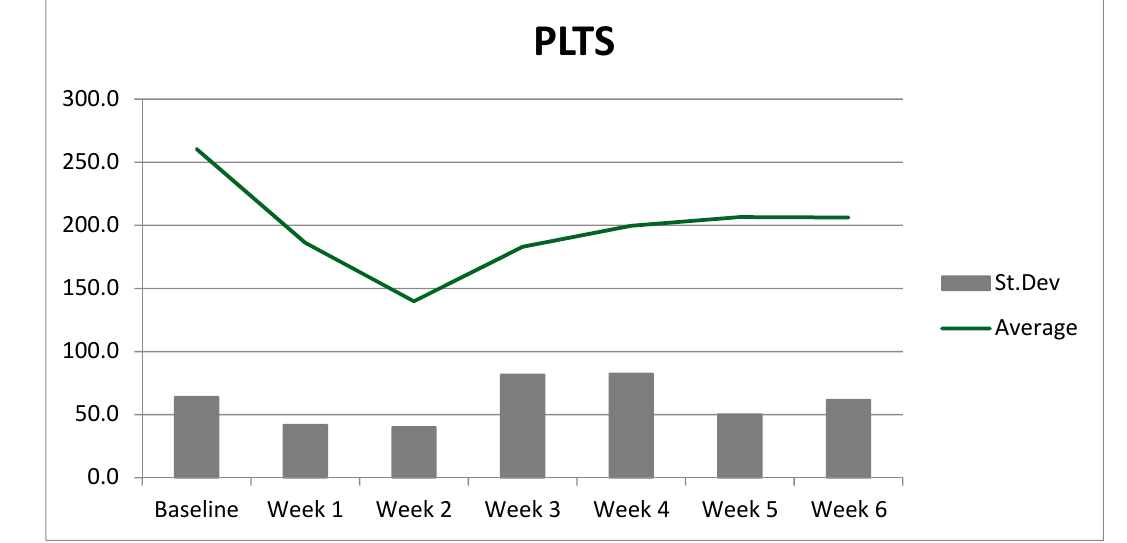
Figure A3. Platelet count trend during treatment.